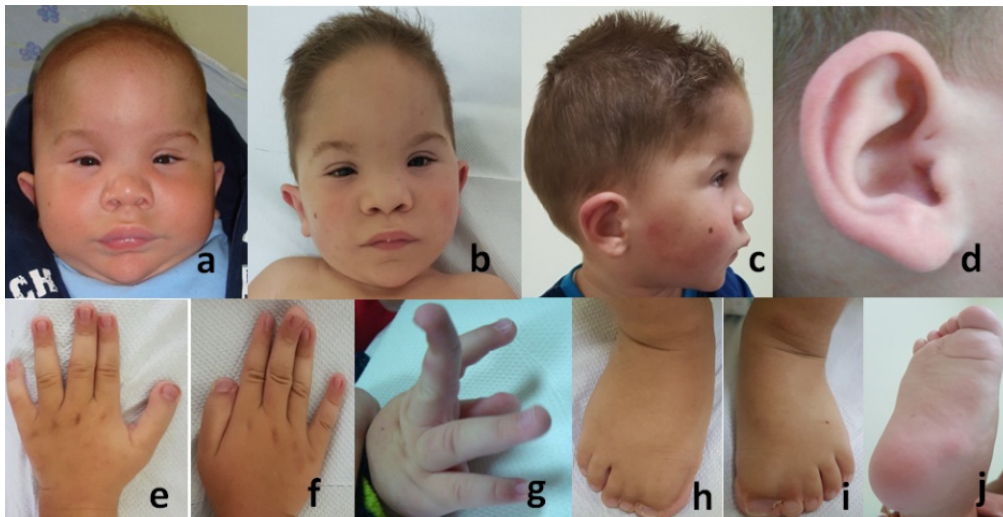
Figure 1. ( a – d ) shows cranio-facial features of the patient: macrocephaly at the age of 1 year ( a ), and macro-acrocephaly at 3 years ( b , c ); prominent high anterior hairline with right frontal upsweep; sparse eyebrows, hypertelorism, telecanthus, and upslanted palpebral fissures; convergent strabism; depressed and wide nasal bridge, anteverted nares, and broad nasal base with broad and high inserted columella; long and broad philtrum, and deep naso-labial fold; thick upper lip; pointed chin with a horizontal deep crease; pigmented nevus on the right cheek ( a – c ); low inserted ears with out-sticking upper one-third of the pinnae, and a pit on the crus of the helix ( c , d ). ( e – j ) Digital anomalies of the hands and feet: squared broad thumbs ( e , f ); joint laxity with dorsiflexion of the distal phalanges ( f , g ); broad hallux with cutaneous complete syndactyly of interdigital spaces I–II and II–III on both feet; bilateral ped planus ( h , i ) and deep horizontal cutaneous skin crease at the base of the hallux ( j ).